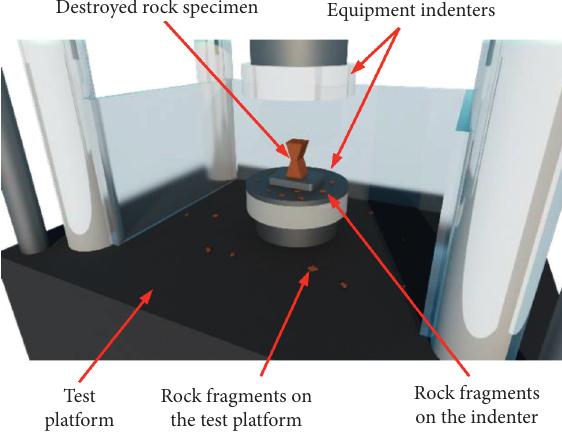
Figure 9: Calculation schematic of M